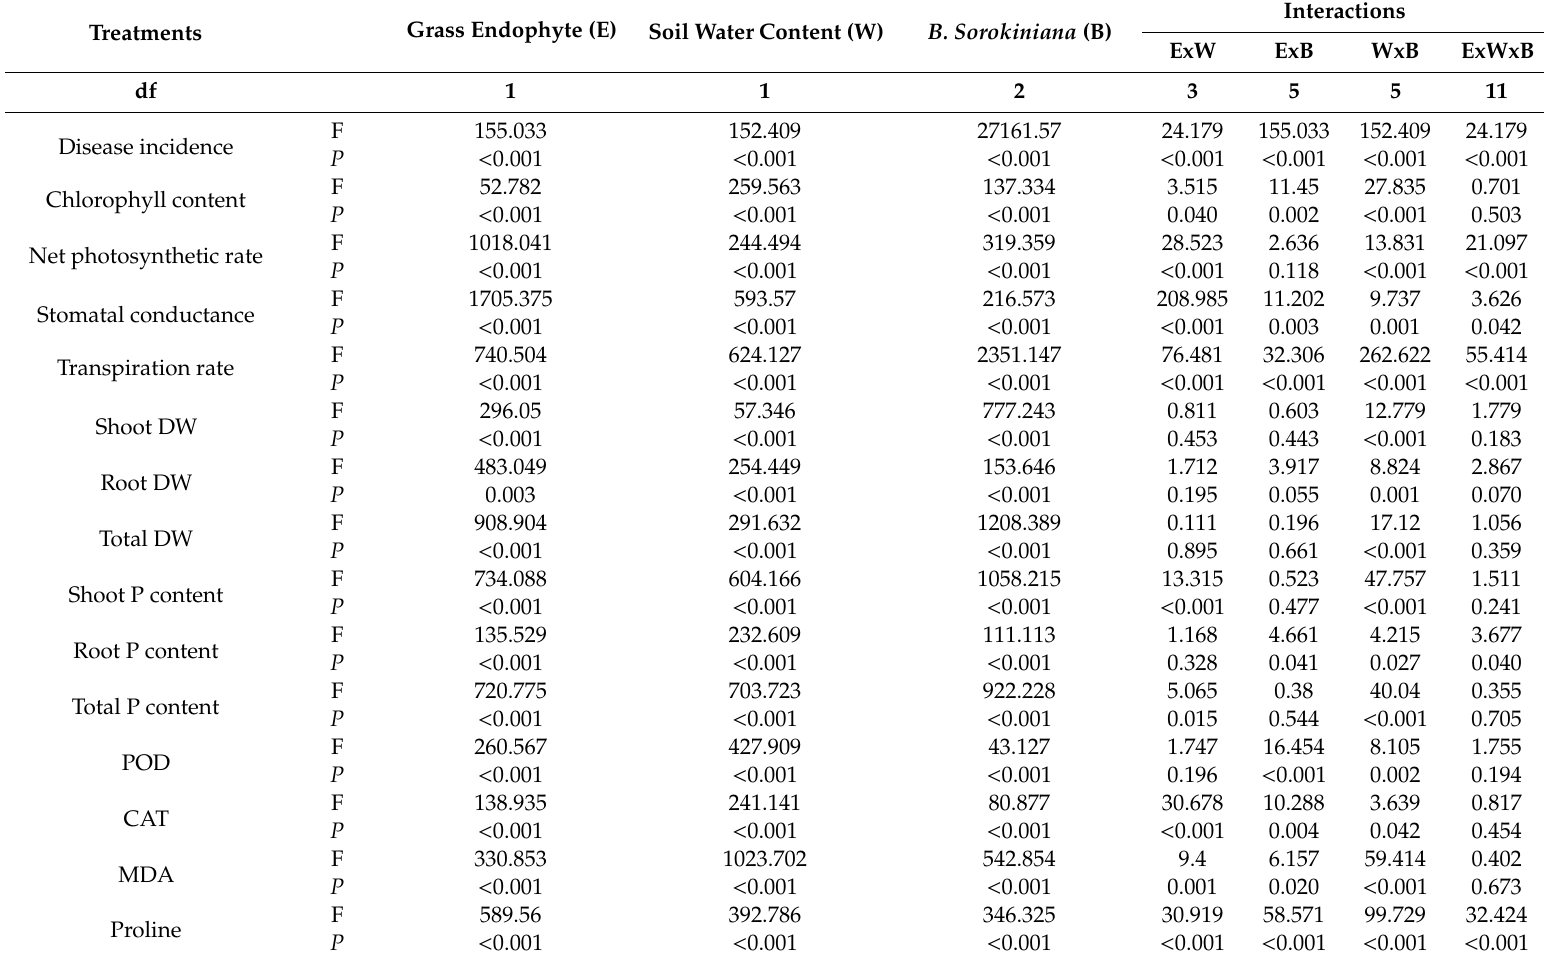
Table 1. ANOVA result for e ff ects of fungal endophyte (E), B. Sorokiniana (B), and soil water regime (W), and their interactions on the listed variables. Treatments Grass Endophyte